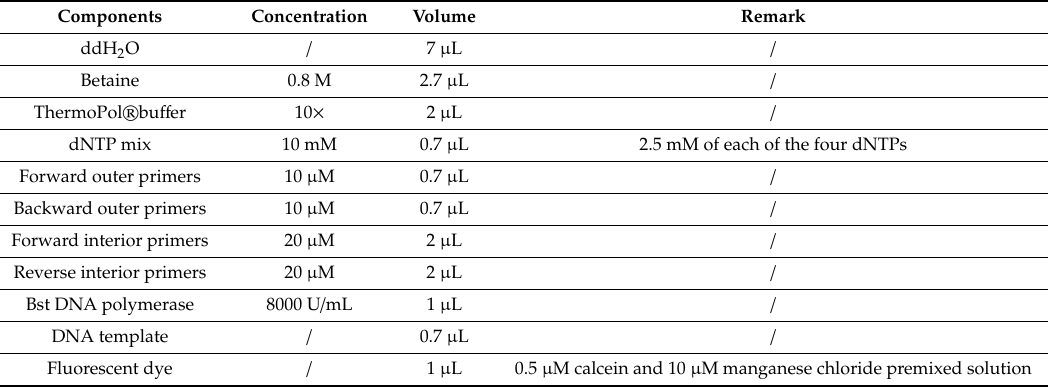
Table 1. The components of the digital LAMP